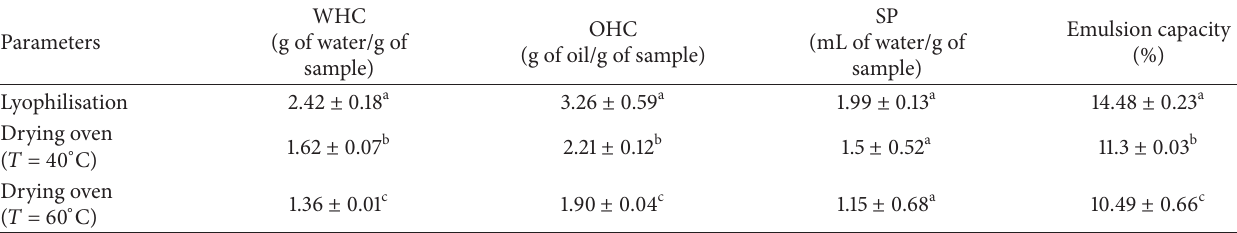
Table 4: Effect of drying process on the technofunctional properties of inulin extracted from Agave americana leaves. WHC SP OHC Emulsion capacity Parameters (g of water/g of (mL of water/g of (g of oil/g of sample) (%) sample) sample) Lyophilisation 2.42 ± 0.18 a 3.26 ± 0.59 a 1.99 ± 0.13 a 14.48 ± 0.23 a Drying oven 1.62 ± 0.07 b 2.21 ± 0.12 b 1.5 ± 0.52 a 11.3 ± 0.03 b ( 𝑇 = 40 ∘ C) Drying oven 10.49 ± 0.66 c ( 𝑇 = 60 ∘ C)